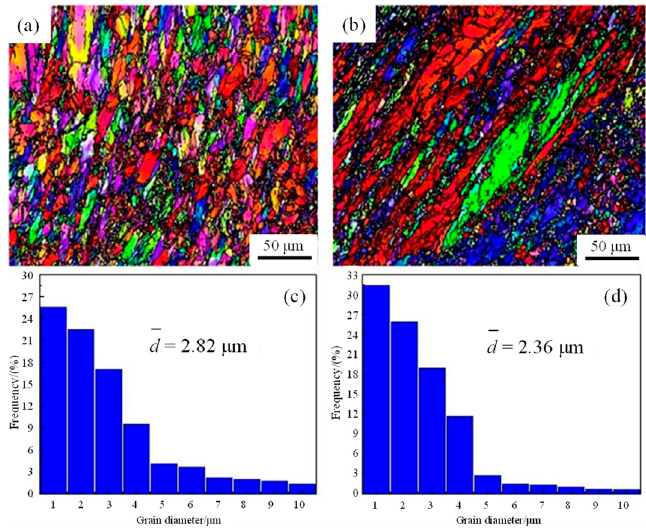
Figure 6. EBSD images under different routes [47]: ( a ) B C route; ( b ) B 135 route; ( c , d ) are the corre- sponding grain size histograms, respectively. Reproduced with permission from IOP Publishing Ltd.